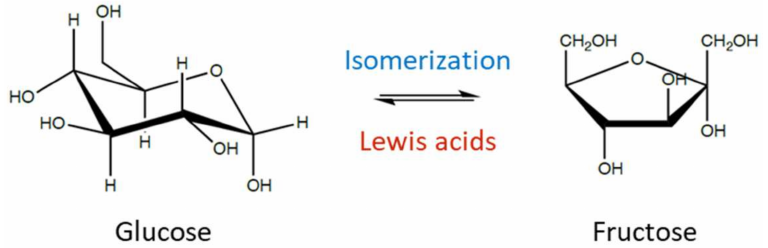
Figure 2. Glucose/fructose isomerization